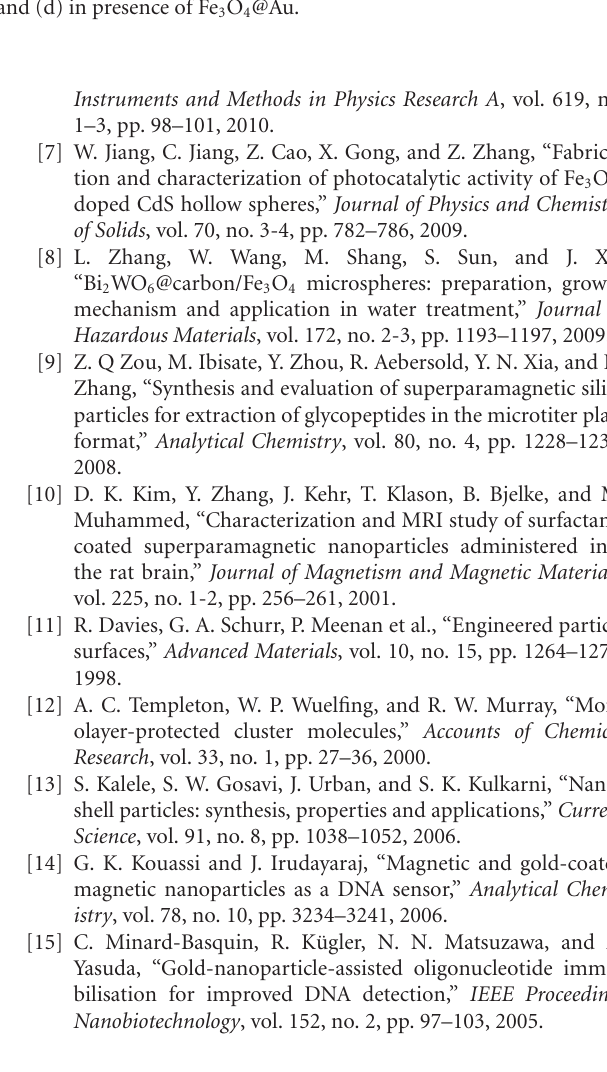
Figure 8: HPLC chromatograms for the photodegradation of 20mg/L − 1 chloridazon using di ff erent synthesized nanoparticals: (a) chlo- ridazon, (b) in absence of nanocomopsites, (c) in presence of Fe 3 O 4 , and (d) in presence of Fe 3 O 4